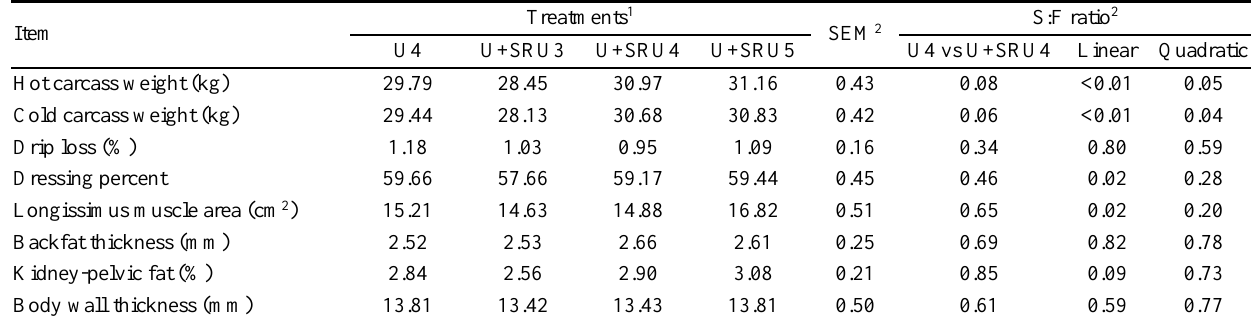
Table 3. Treatment effects on carcass characteristics